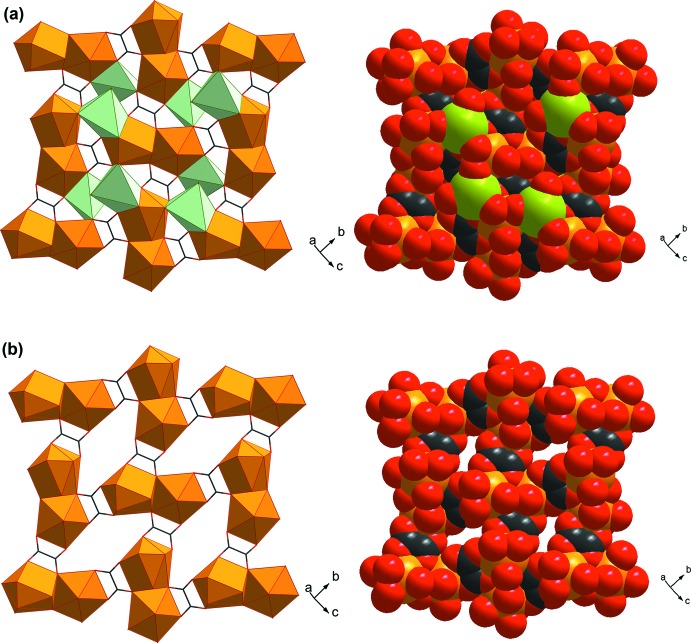
Polyhedral and space-filling representations of the EuIII–oxalate–carboxyl­ate layers (a) with TPR-{EuIIIO6} motifs and (b) without TPR-{EuIIIO6} motif.